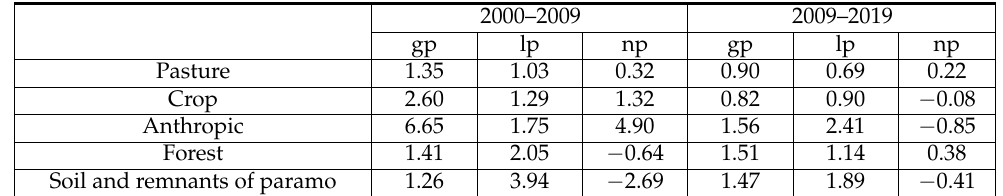
Table 10. Persistence coefficients of the gains, losses, and net changes in the time intervals 2000–2009 and 2009–2019.